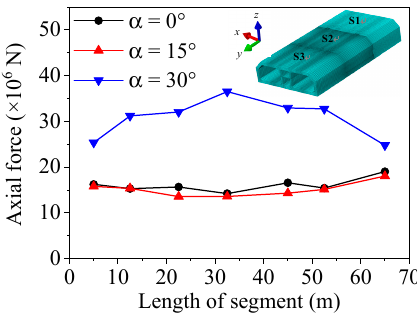
Appl. Sci. 2022 , 12 , 10440 Figure 18. Curves of axial force of segment at different angles of incidence. Figure 18. Curves of axial force of segment at different angles of incidence.